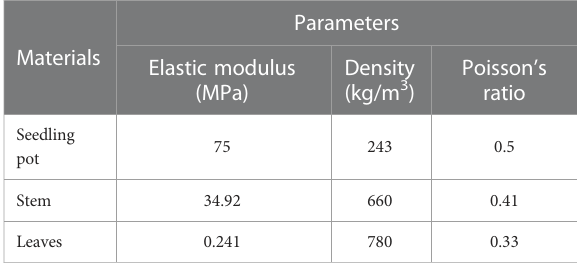
TABLE 2 Model parameters de fi nition of plug